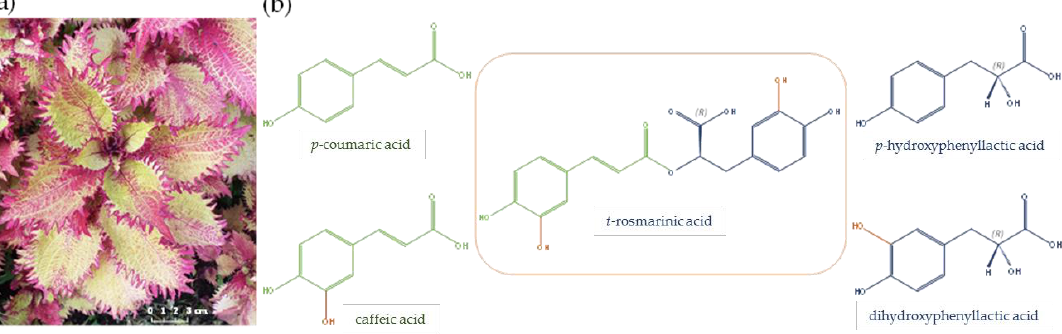
Figure 1. ( a ) Painted nettle ( Plectranthus scutellarioides (L.) R.Br.) leaves morphology; ( b ) Chemical structures of p -coumaric acid, caffeic acid, p -hydrophenyllactic acid, dihydrophenyllactic acid, and trans -rosmarinic acid (picture taken by C.H.).